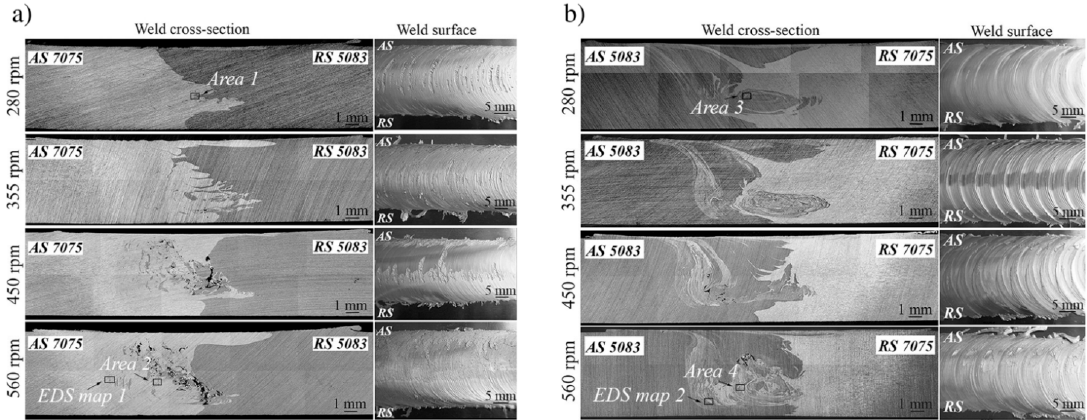
Figure 7. Cross sectional and top surface photos of an ( a ) AS 7075–RS 5083 weld and ( b ) an AS 5083–RS 7075 weld (AS—advancing side, RS—retreating side), whereas marked areas indicate further microstructural analysis; Triflute pin employed [16], with permission from the authors.